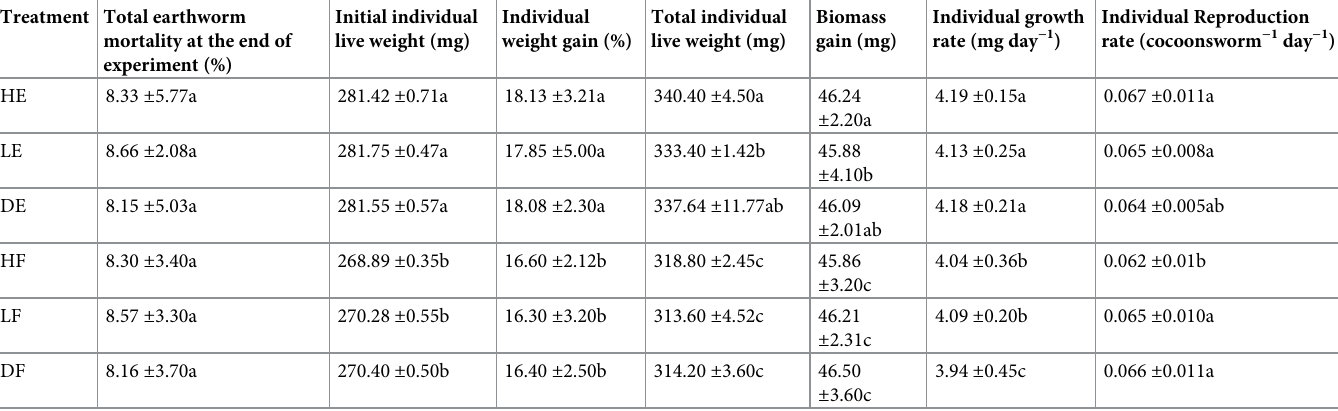
Table 3. Earthworm growth and reproduction rate in different treatments (mean ± S.D., n = 3). Treatment Total earthworm mortality at the end